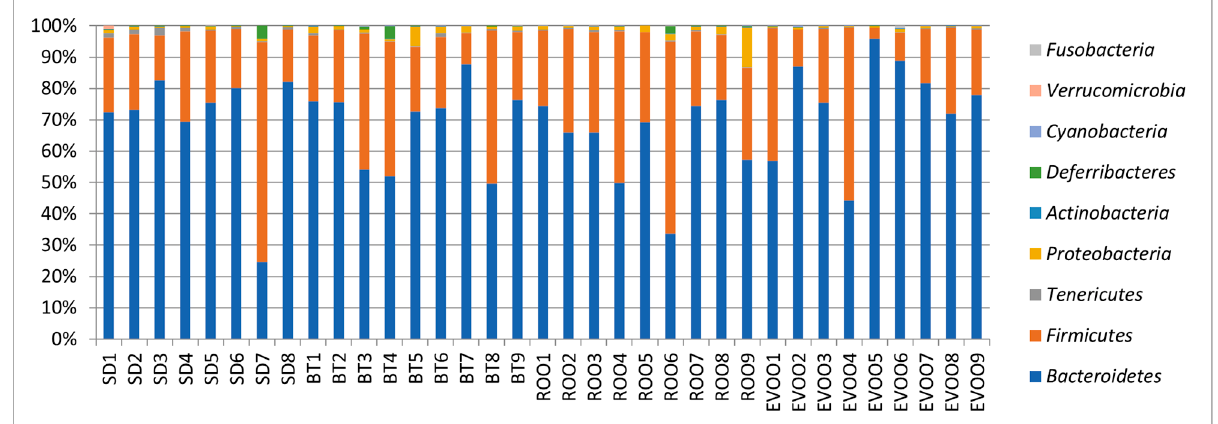
Figure 2. Global bacterial phyla distribution for each diet as a percentage of total sequences retrieved from fecal samples after six weeks of diet. Each column corresponds to one animal fed a diet enriched with butter (BT), extra virgin olive oil (EVOO), refined olive oil (ROO), or standard chow (SD). SD, EVOO, and BT diet values from [17].